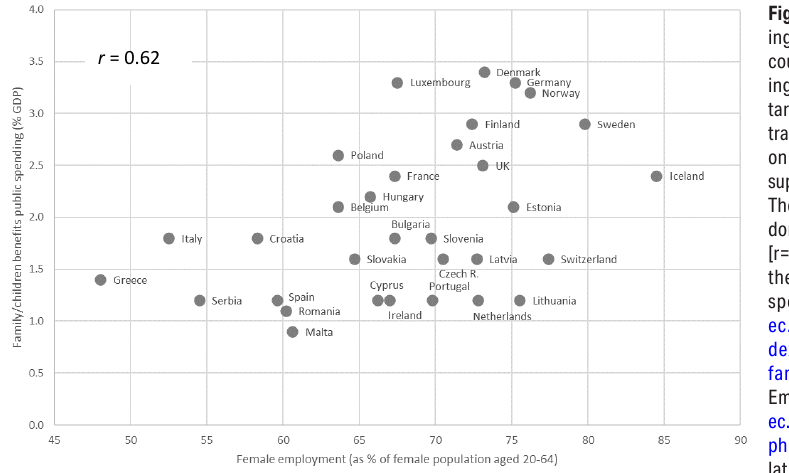
Figure 3. Female employment versus public spend - ing on family/children benefits across 32 European countries in 2017. Family/children benefits spend - ing refers to public spending and financial support targeting families and children. It includes cash transfers to families with children, public spending on services for families with children, and financial support for families provided through the tax system. The indicator is measured as a percentage of gross domestic product (GDP). [r=Pearson correlation coefficient weighted on the country population sizes]. Sources: